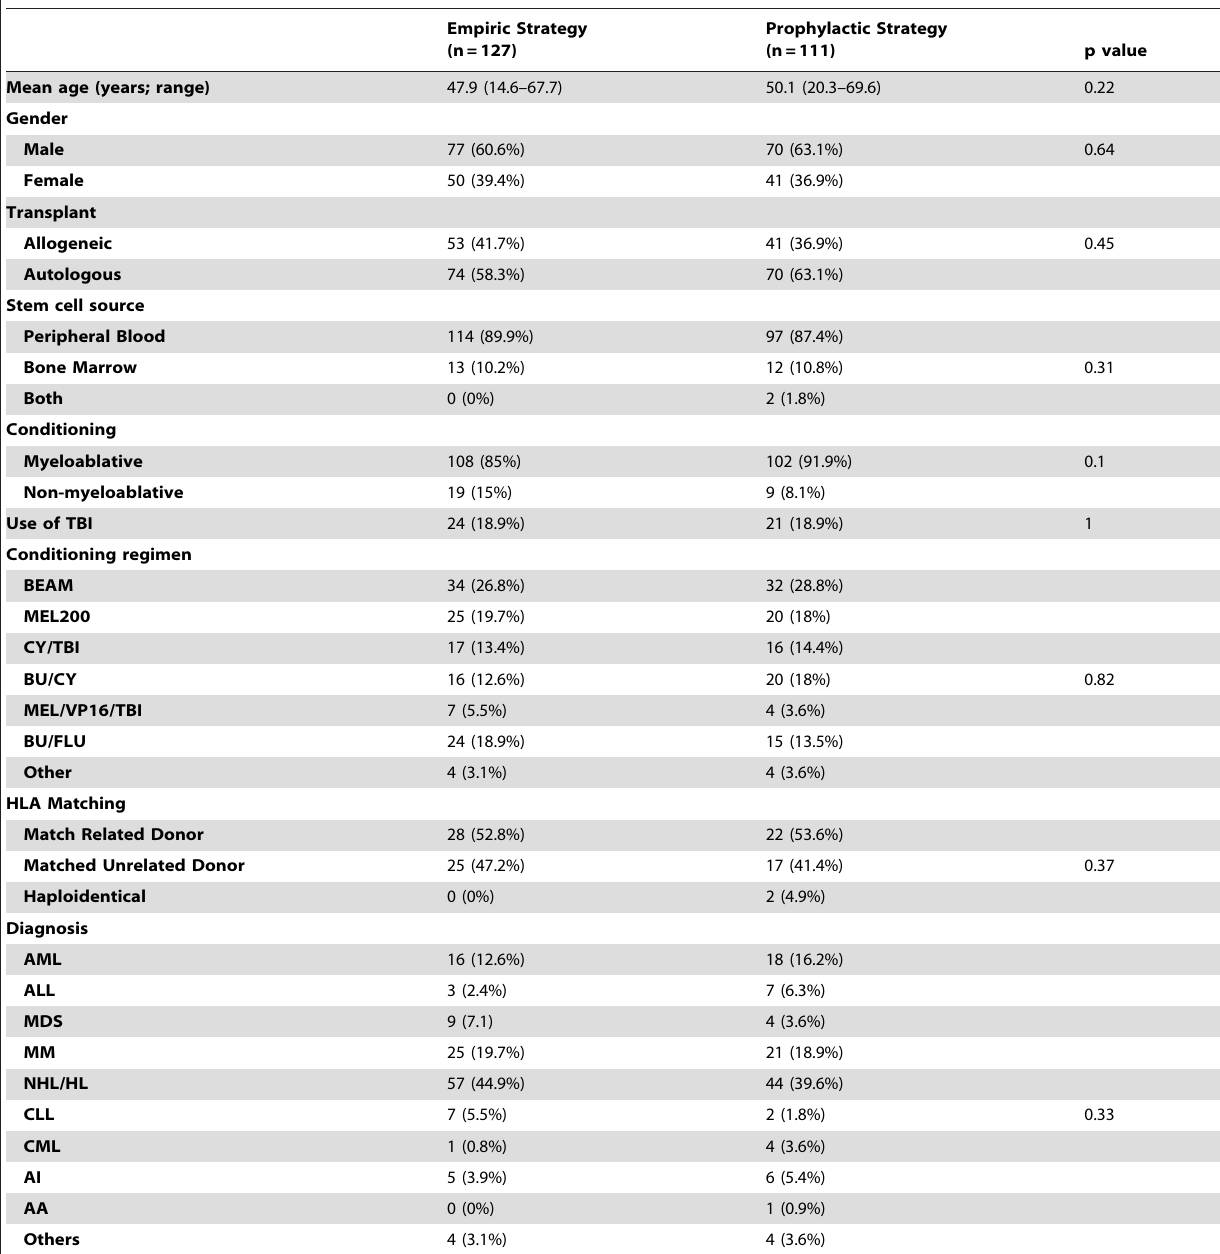
Table 2. Baseline